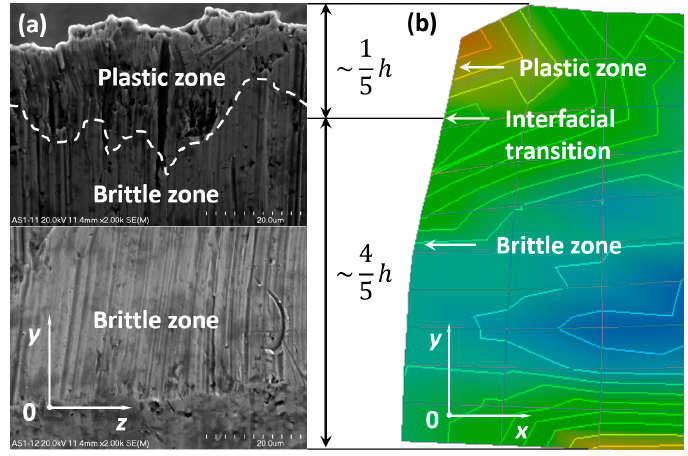
Figure 9. Comparison of the experimental ( a ) and numerical results ( b ) for the top sheet in a bundle.